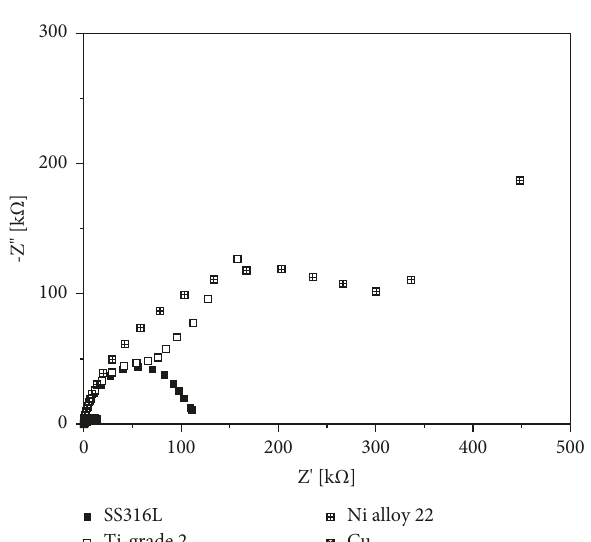
Figure 2: Nyquist plots of SS316L, Ti-Gr.2, Alloy 22, and Cu in naturally aerated KURT groundwater with the addition of 0.1 M NaCl.